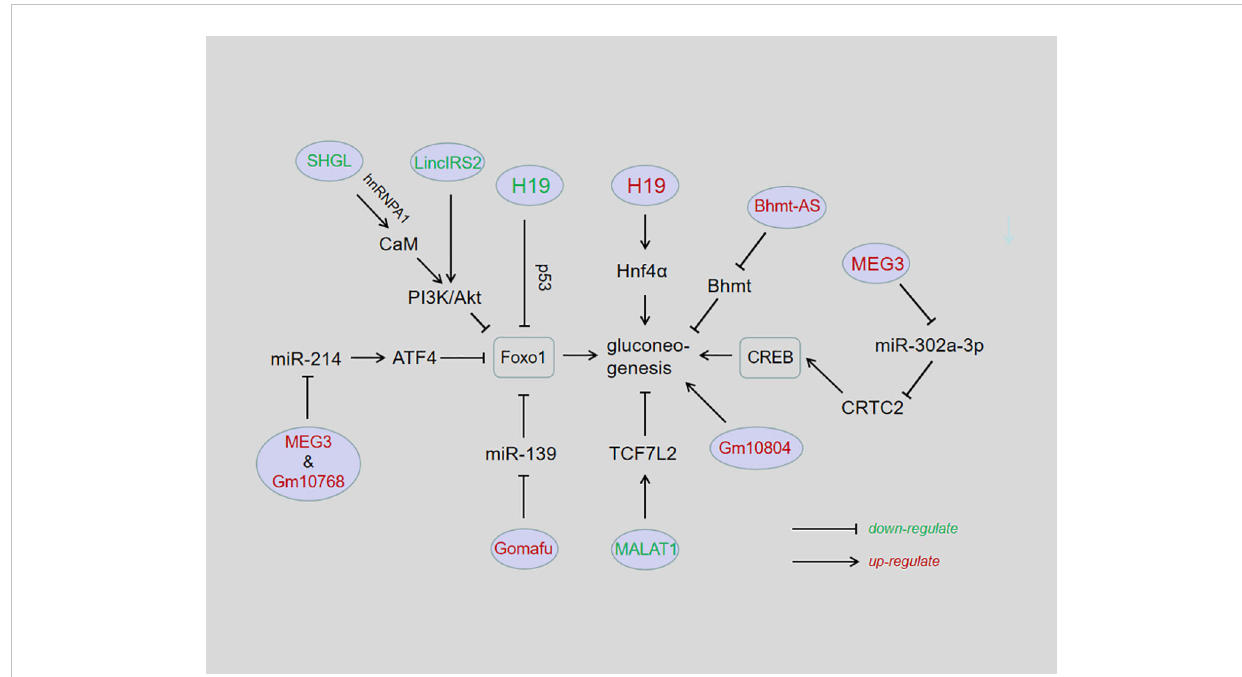
FIGURE 1 In fl uences of lncRNAs in hepatic gluconeogenesis. In general, lncRNAs affect hepatic gluconeogenesis in the following ways: lncRNAs directly regulate the expression of gluconeogenic genes, such as lncH19, lncSHGL, lncBhmt-AS, lcnMALAT1, lincIRS2, and lncGm10804; lncRNAs interact with miRNAs as competitive endogenous RNAs, such as lncMEG3/miR214; lncGm10768/miR214; lncRNAs act as microRNA molecular sponges to block subsequent pathways, such as lncH19/miRlet-7; lncMEG3/miR302-a-3p; lncGomafu/miR139; or lncRNAs bind to the promoter to affect gene transcription, such as